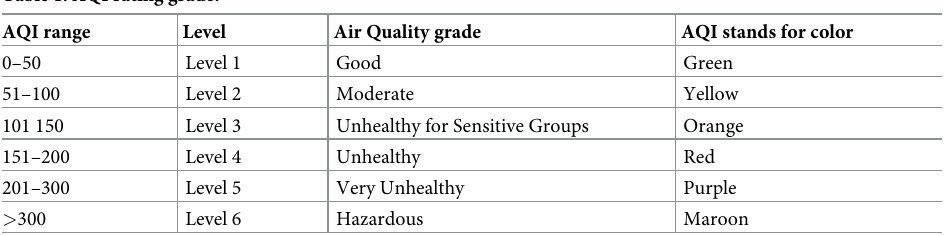
Table 1. AQI rating